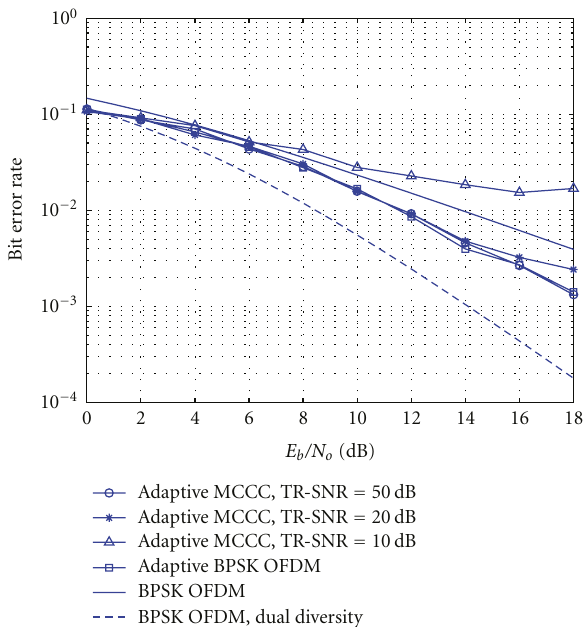
Figure 13: Bit error rate performance of adaptive MCCC technique using the first subcarrier allocation strategy for di ff erent TR-SNR.